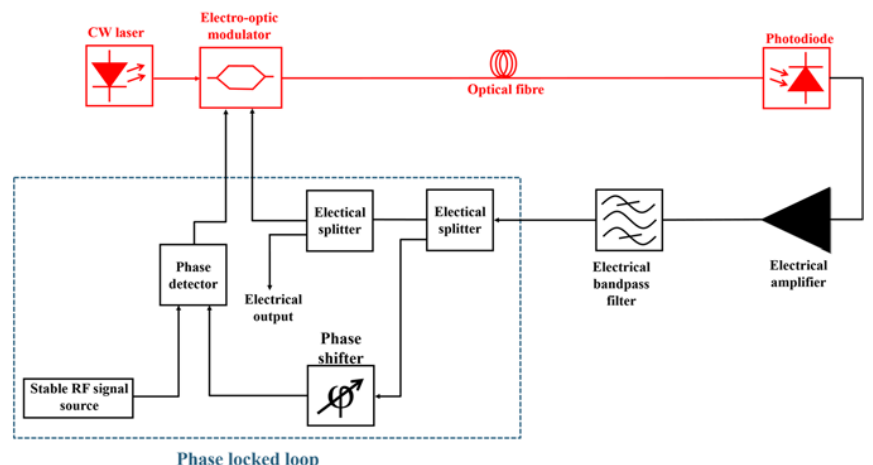
Figure 7. Typical configuration of an OEO with a PLL configuration.